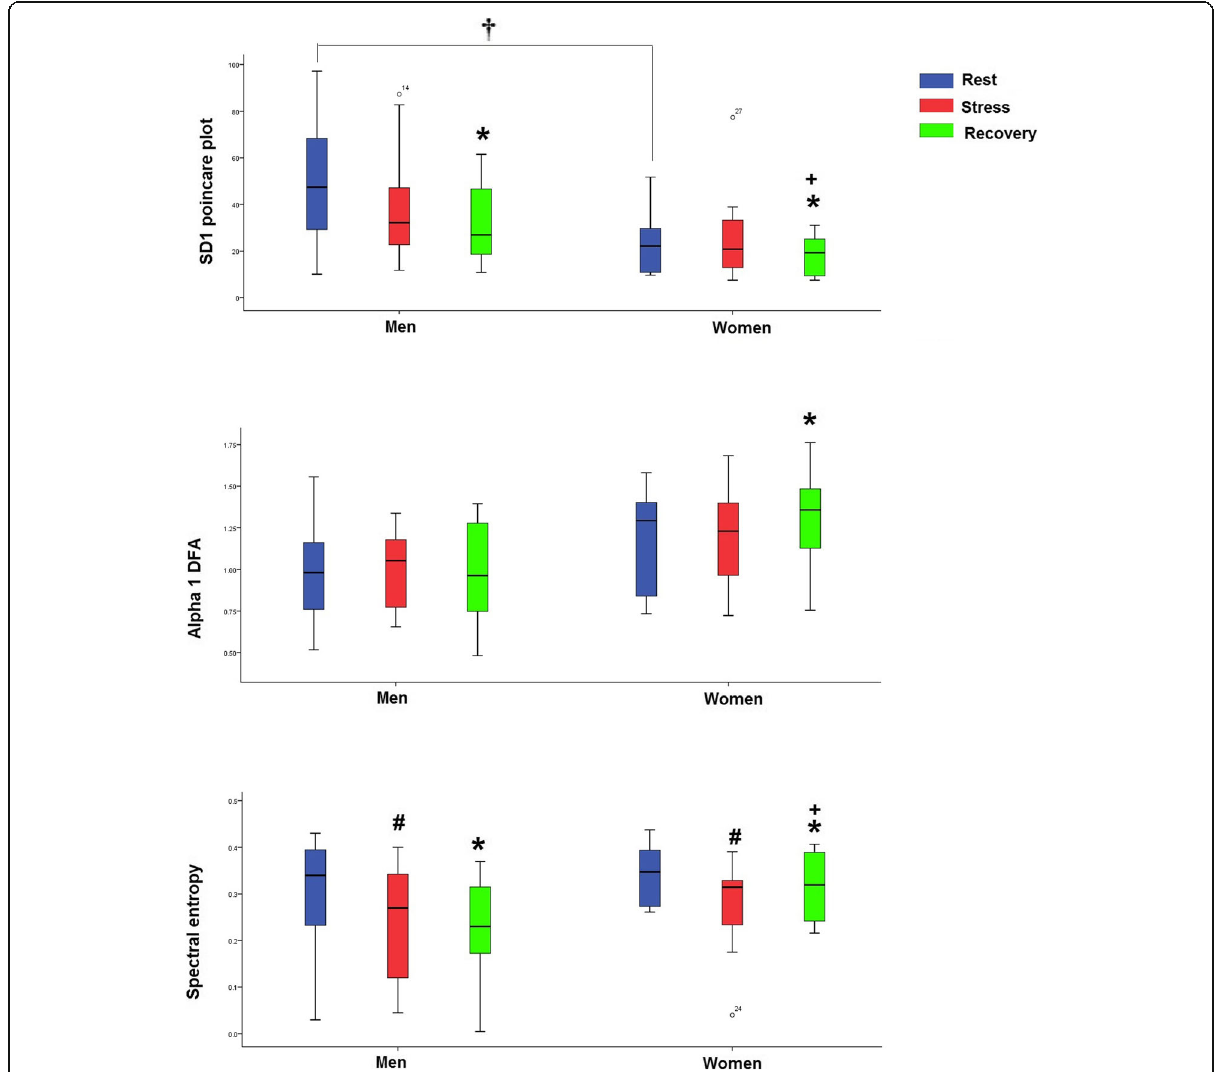
Fig. 6 The box plot of SD1 Poincaré, alpha 1 of DFA, and spectral entropy in the men and women and in three phases of the test. *, the significance between rest and recovery; #, the significance between rest and stress condition; +, the significance between stress condition and recovery; † , the significance between men and women. Alpha 1 of DFA index increased after stress and recovery only in women (between rest and recovery: Z of Wilcoxon ’ s test= − 2. 9, p <0.004; between stress and recovery: Z of Wilcoxon ’ s test= − 2. 27, p <0.02). There was no significant difference between genders